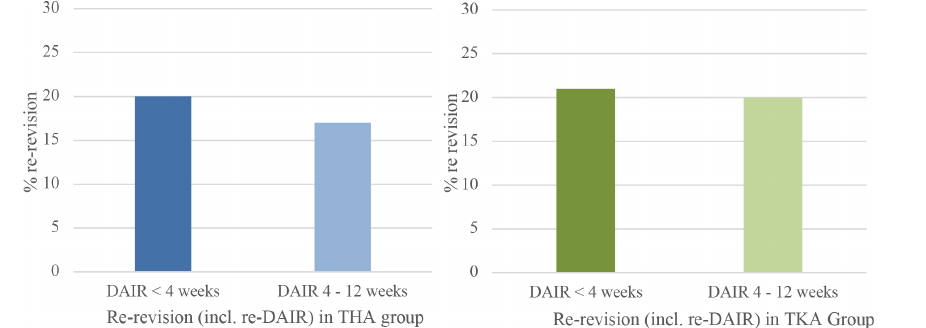
Figure 4. Percentage of re-revision including repeat-DAIR procedure within 1 year when DAIR is performed for acute postoperative PJI < 4 weeks after primary surgery or between 4 and 12 weeks. Blue graph for THA and green for TKA. Table 3. Number of re-revisions after DAIR procedures with odd ratios for different timings of DAIR after primary TKA. Complete revision OR (CI) Re-revision < 1